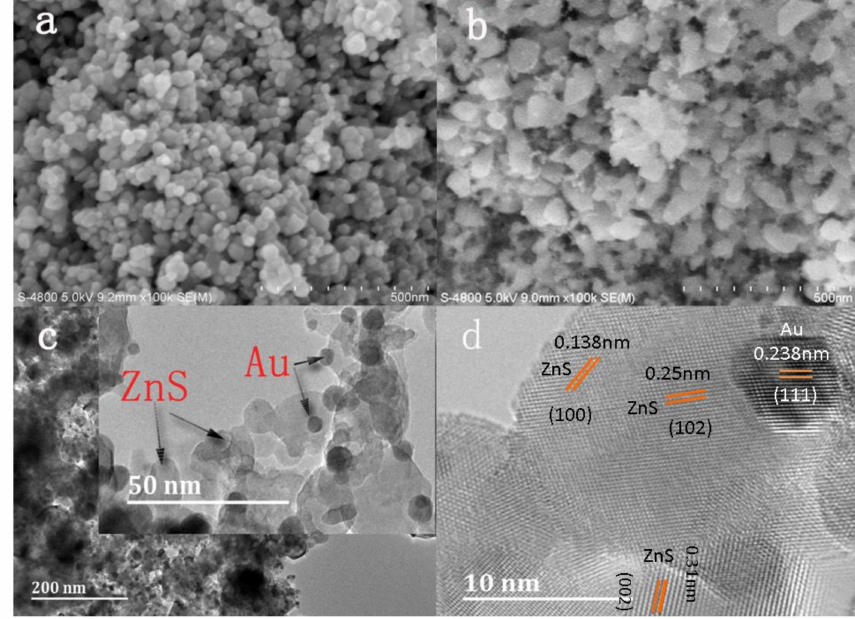
Figure 2. SEM image of ( a ) pristine ZnS nanosphere and ( b ) Au-decorated Ni-doped ZnS nanospheres after annealing. ( c ) TEM image and ( d ) HRTEM image of Au-decorated Ni-doped ZnS